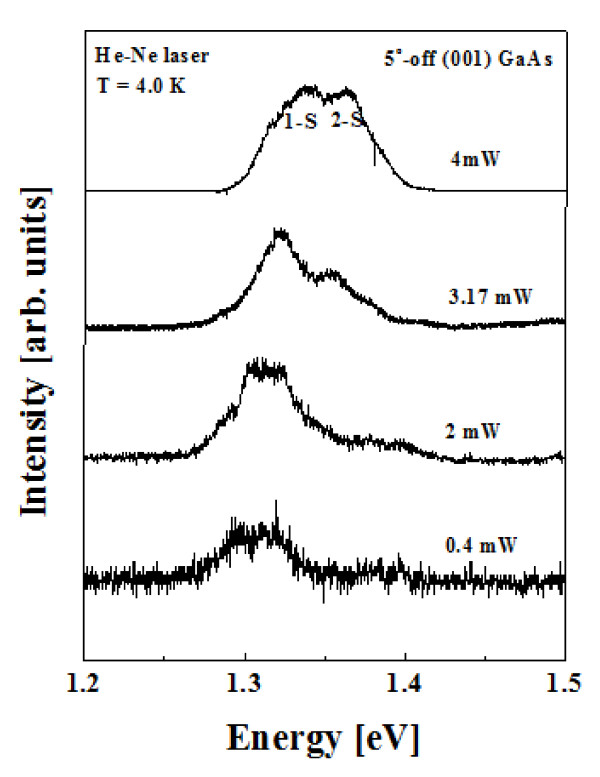
μ-PL spectra of an In0.8Ga0.2As SAQDs ensemble grown on SiO2-patterned 5°-off (001) GaAs substrate with the excitation power of He-Ne laser were (a) 0.4, (b) 2, (c) 3.17, and (d) 4 meV, respectively. (W(001):150 nm).